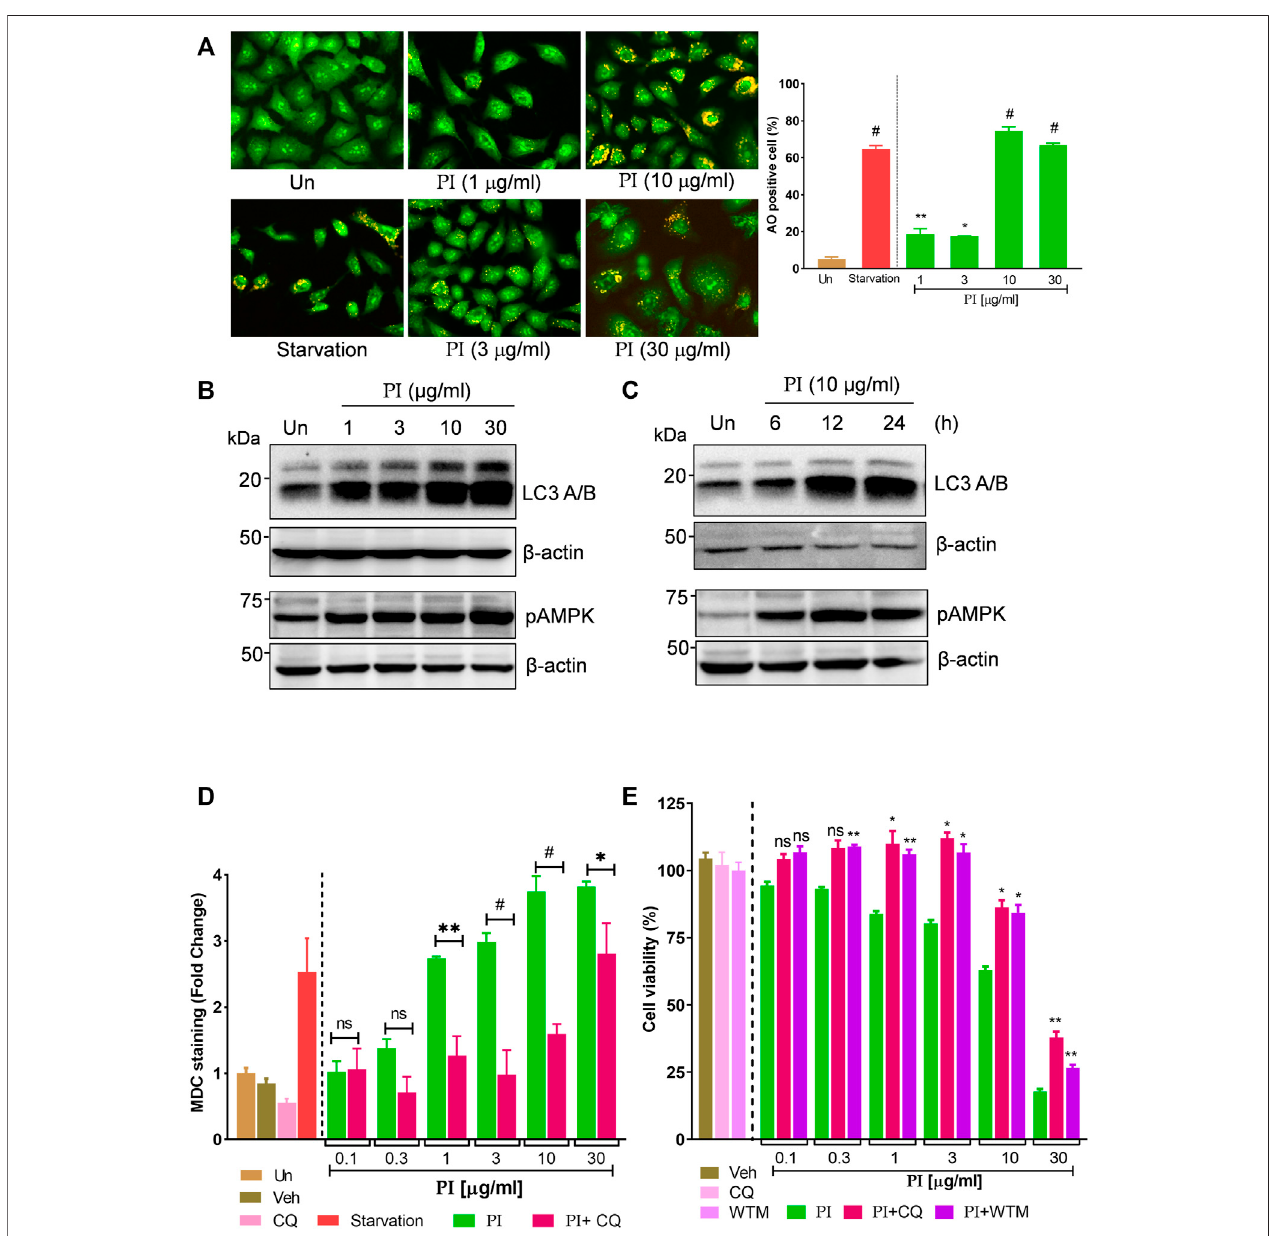
FIGURE 4 | Pistacia integerrima induces AMPK-dependent autophagic cell death in lung cancer cells. (A) Acridine orange staining of A549 cells post 24 h treatment with PI at indicated doses. Each image is zoomed in to clearly show the acidic vacuoles. The right panel shows the percentage of cells positive for acidic vesicular organelles (AO) in each treatment. Signi fi cance is evaluated with respect to untreated. (B) Whole cell lysates of A549 cells, post 24 h of treatment at indicated doses, were subjected to Western blotting using antibodies against LC3 A/B and pAMPK. β -Actin served as a loading control. (B) Whole cell lysates of A549 cells treatedat10 μ g/mlofPIfor6,12,and24 htimeperiodsweresubjectedtoWesternblottingusingantibodiesagainstLC3A/BandpAMPK. β -Actinservedastheloading control. (D) A549cellstreatedwithPIaloneortogetherwithchloroquine(CQ)for24 hwerestainedwithMDC.Fluorescencewasexpressedasfoldchangewithrespect tountreated.Asigni fi cantdifferenceinfoldchangeofMDCstainingiscalculatedinPI+CQtreatmentwithrespecttoPI. (E) CellviabilitywithAlamarbluewasassessedin A549cellstreatedwithindicatedtreatmentsfor24 h.Cellsweretreatedwithchloroquine(CQ)at10 μ Mandwortmannin(WTM)at500 nMconcentration.Signi fi cancein PI+CQandPI+WTMiscalculatedwithrespecttoPIalone.Errorbarsrepresentmean±SEM;signi fi canceofdatarepresentedas* p < 0.05,** p < 0.005,*** p < 0.0005, and # p < 0.0001 and not signi fi cant (ns) if p > 0.05.